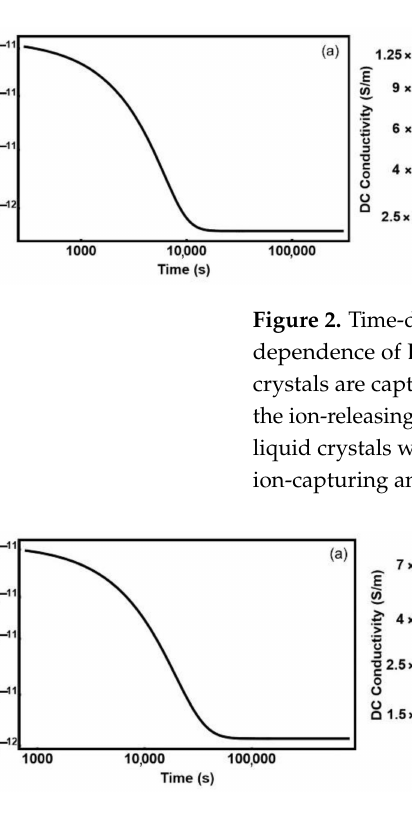
Figure 3. Time-dependent DC conductivity of liquid crystal cells. The cell thickness is 5 µ m. ( a ) Time dependence of DC conductivity caused by the ion-capturing effect (ions already present in liquid crystals are captured by the substrates of the cell). ( b ) Time dependence of DC conductivity due to the ion-releasing effect (ionic contaminants originated from contaminated substrates of the cell enrich liquid crystals with ions). ( c ) Time dependence of DC conductivity caused by the combination of the ion-capturing and ion-releasing processes shown in ( a , b